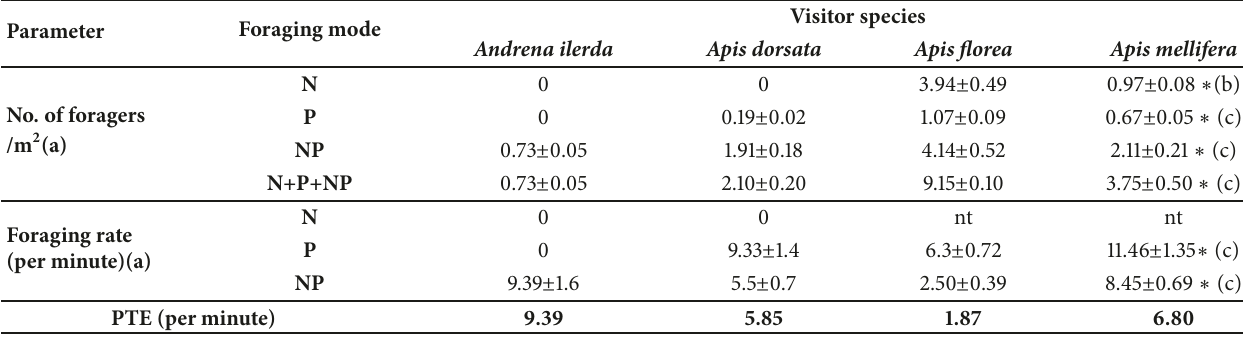
Table 6: Foraging modes, number of foragers, foraging rates, and pollen transfer efficiency of different flower visitors of toria ( Brassica